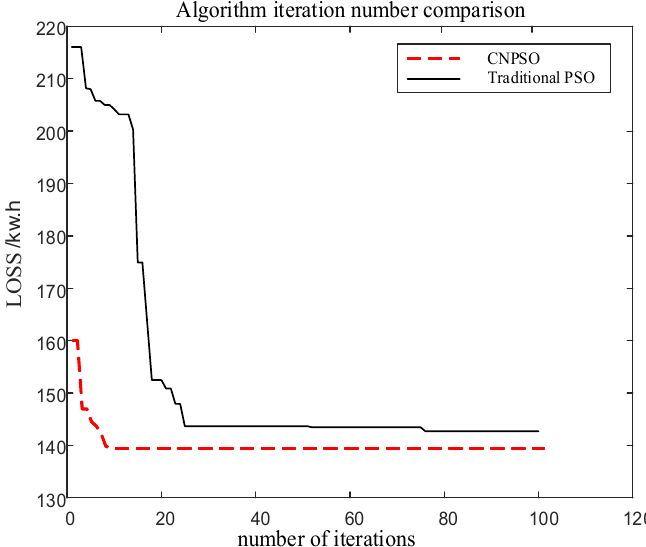
Figure 11. Algorithm iteration number comparison chart.